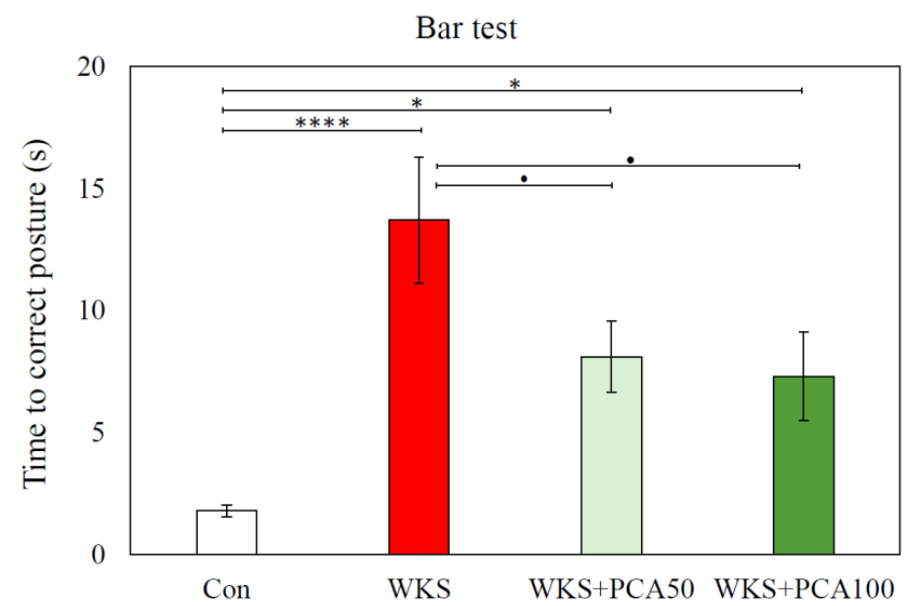
Figure 6. Time (mean ± SEM) needed to correct the imposed body posture in the Bar test, * p < 0.05 vs. Con, **** p < 0.001 vs. Con, • p < 0.05 vs. WKS (ANOVA, post-hoc GH).